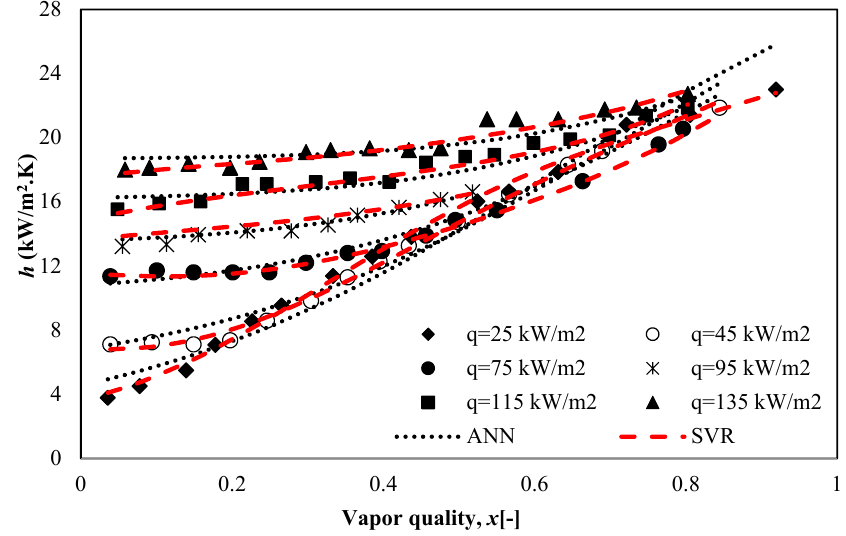
Figure 7. Observed and modeled heat transfer coefficient for R600a in a mini-channel at different heat fluxes (G = 400 kg/m 2 ·s; T sat = 41 °C).